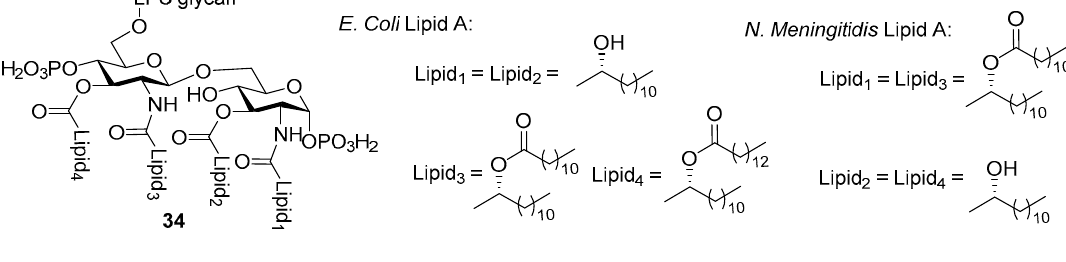
Figure 1. Conservative structure of lipid A as the core of LPS.